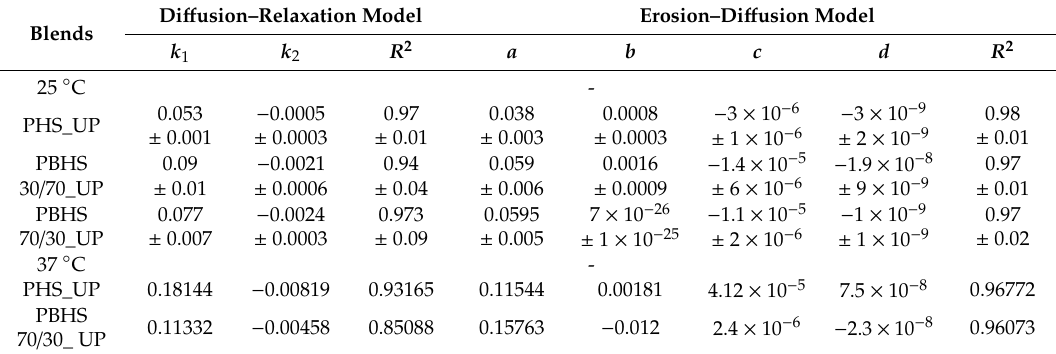
Table 5. Simulation using di ff usion-relaxation model and erosion–di ff usion model.